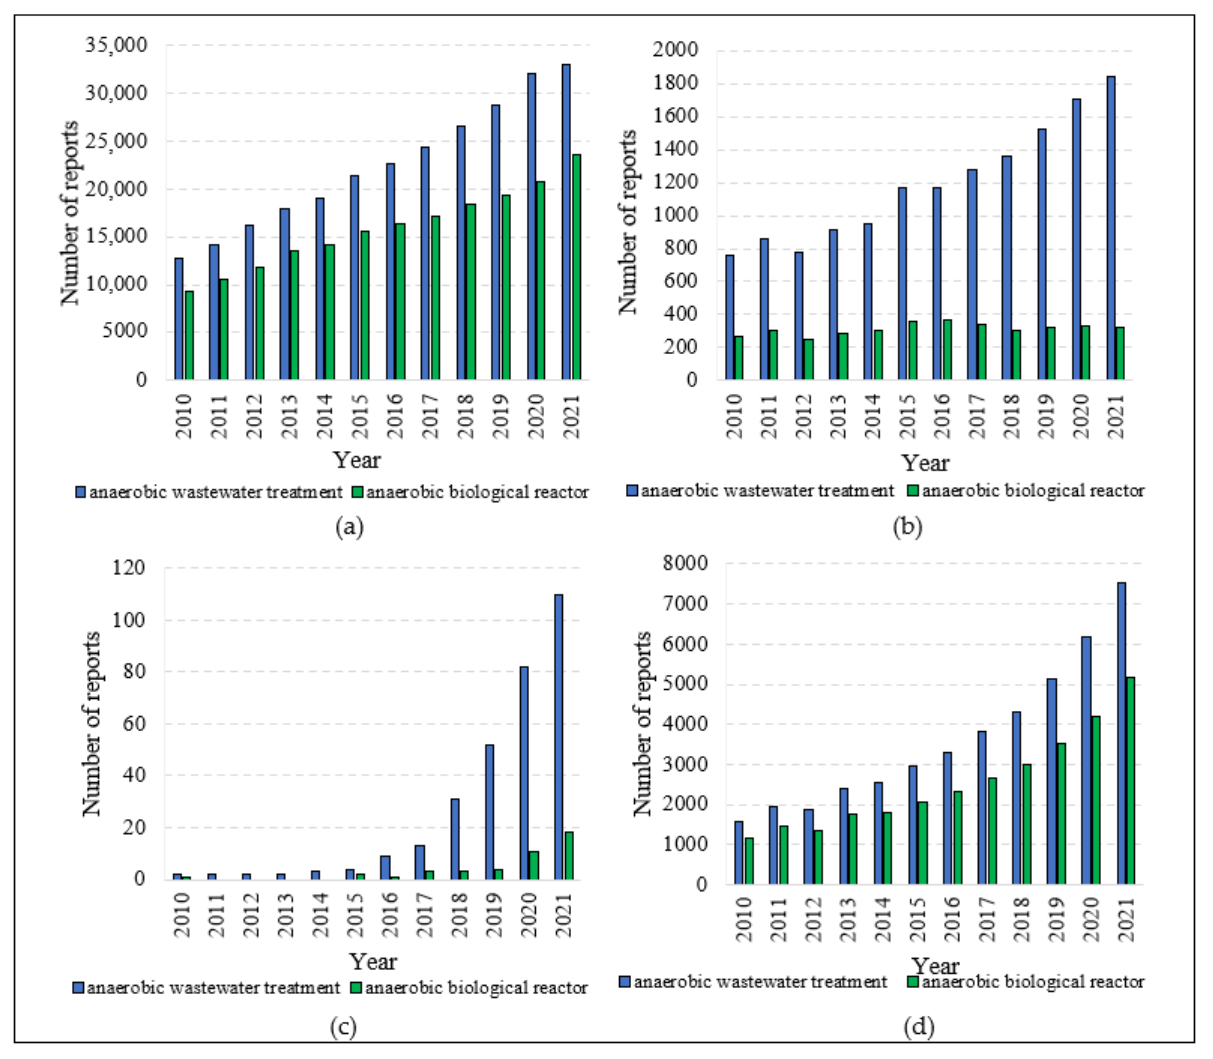
Figure 1. Number of reports searched in ( a ) Google Scholar, ( b ) Scopus, ( c ) MDPI, and ( d ) Science Direct databases in the years 2010–2021 using the keywords “anaerobic wastewater treatment” and “anaerobic biological reactor”, respectively. The statistical results were obtained on 24 September 2022.